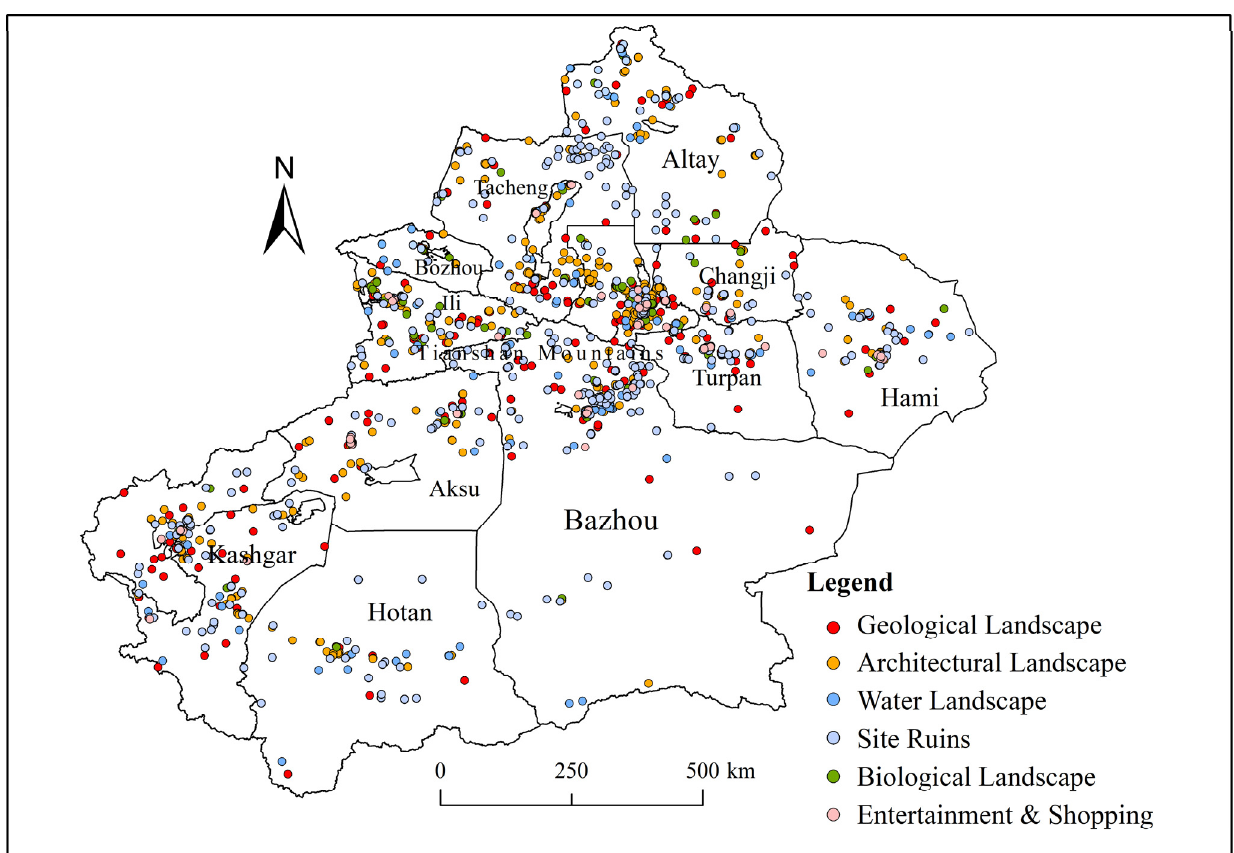
Figure 1. Distribution of tourism resource categories in Xinjiang.